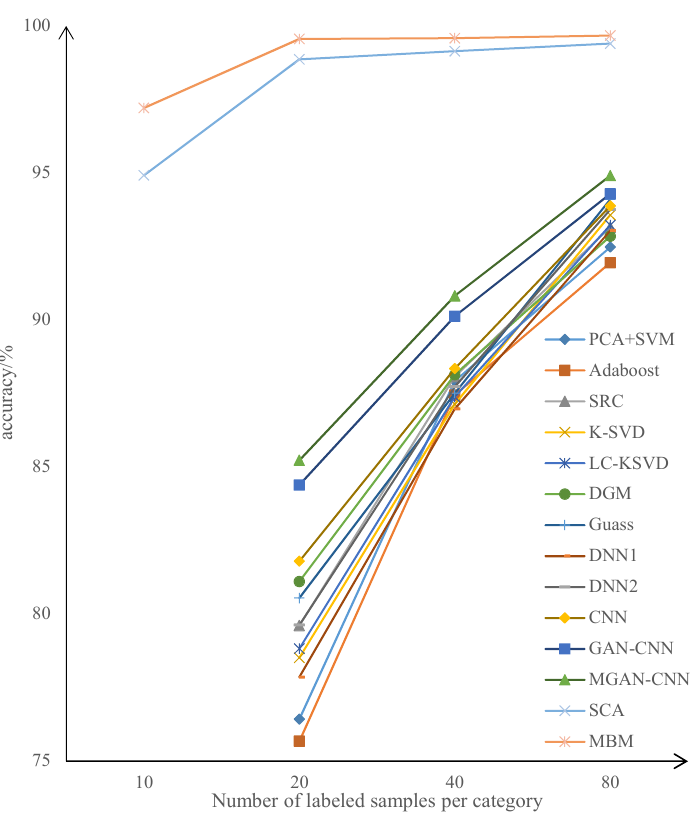
Figure 9. Recognition accuracies of the proposed semi-supervised learning method and the methods for comparison on the MSTAR data